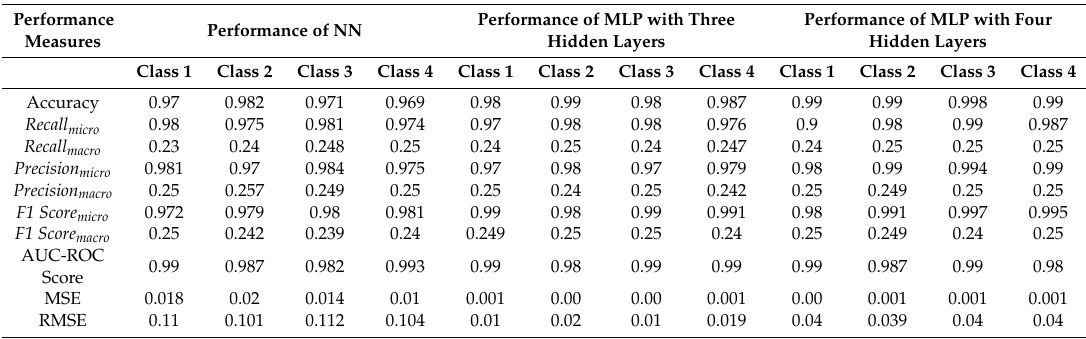
Performance of MLP with Three Hidden Layers